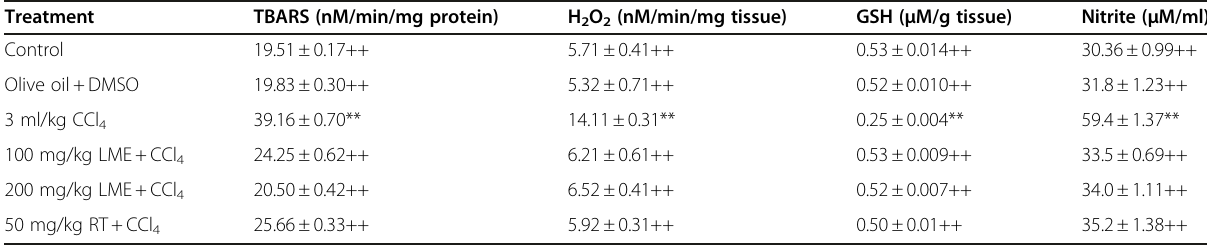
Table 2 Effect of LME on lungs TBARS, H 2 O 2 , GSH and nitrite contents